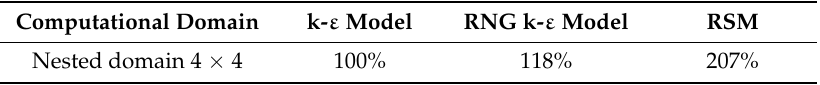
Table 7. Computational time per iteration for different turbulence models and